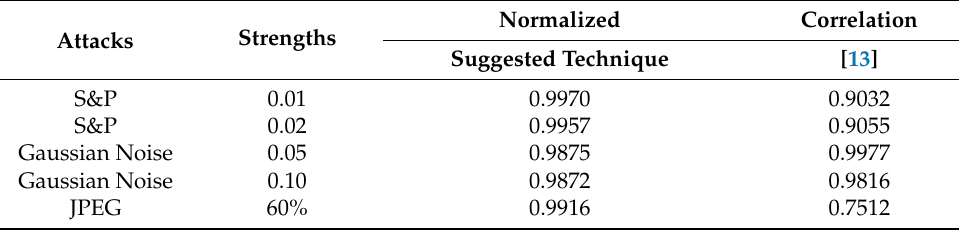
Table 7. Normalized correlation against image processing attacks.